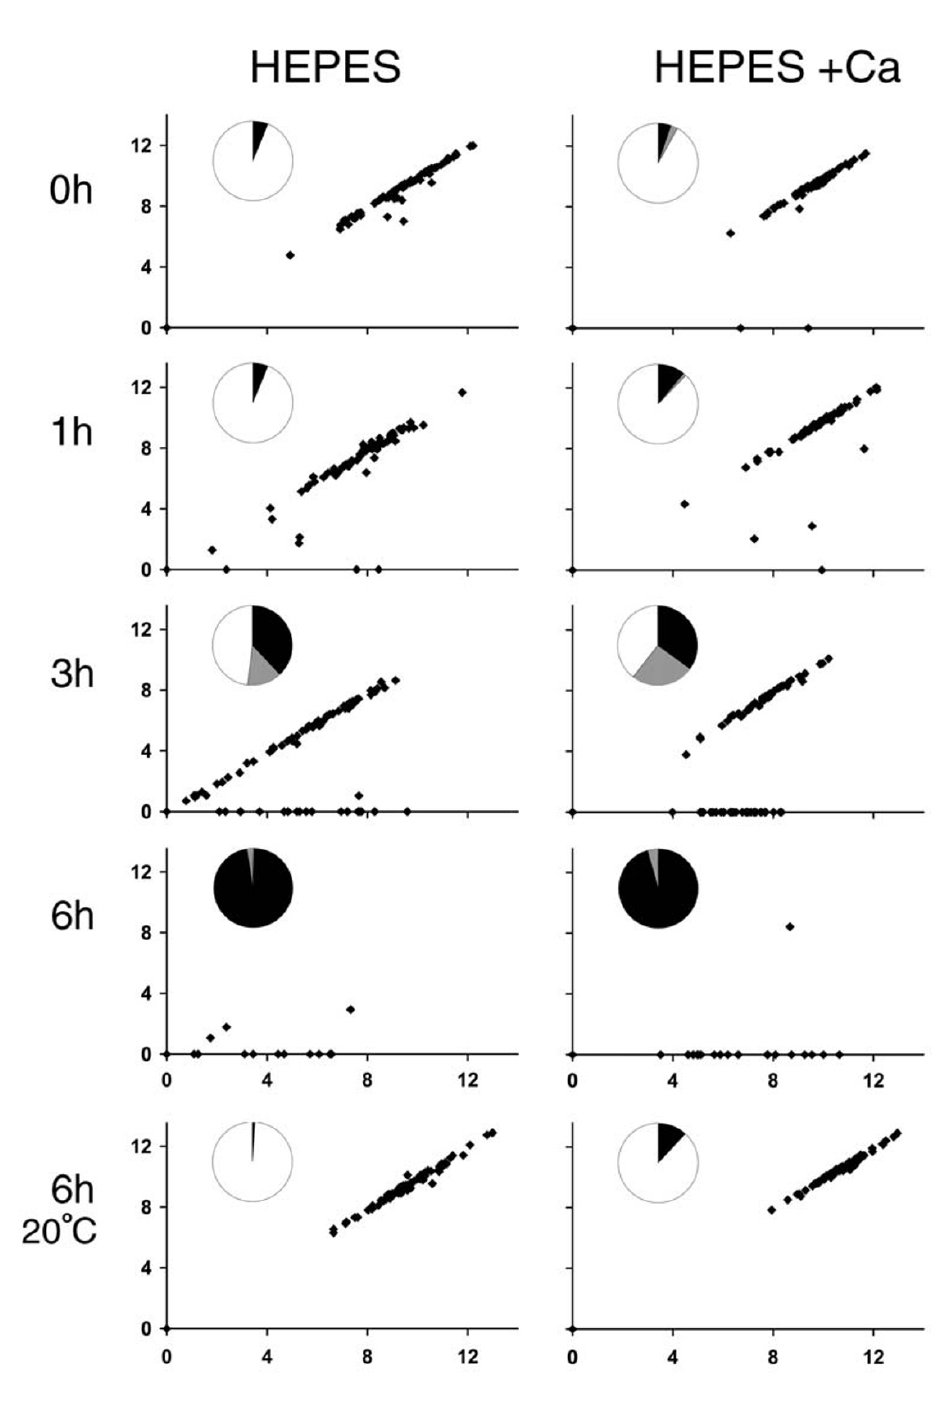
Figure 3 Scatter plots of fla10 timecourses in HEPES and HEPES+Ca. Data shown is the same as fla10 data in Figure 2. Each flagellum from at least 70 cells was measured, and the lengths plotted as the length of the longer flagellum (in µ m) on the X-axis and the length of the shorter flagellum (in µ m) on the Y-axis, such that each point in a graph corresponds to a single cell (except where two points overlap, such as at the origin). Insets show the percent of biflagellate (white), uniflagellate (grey), and bald (black) cells in each